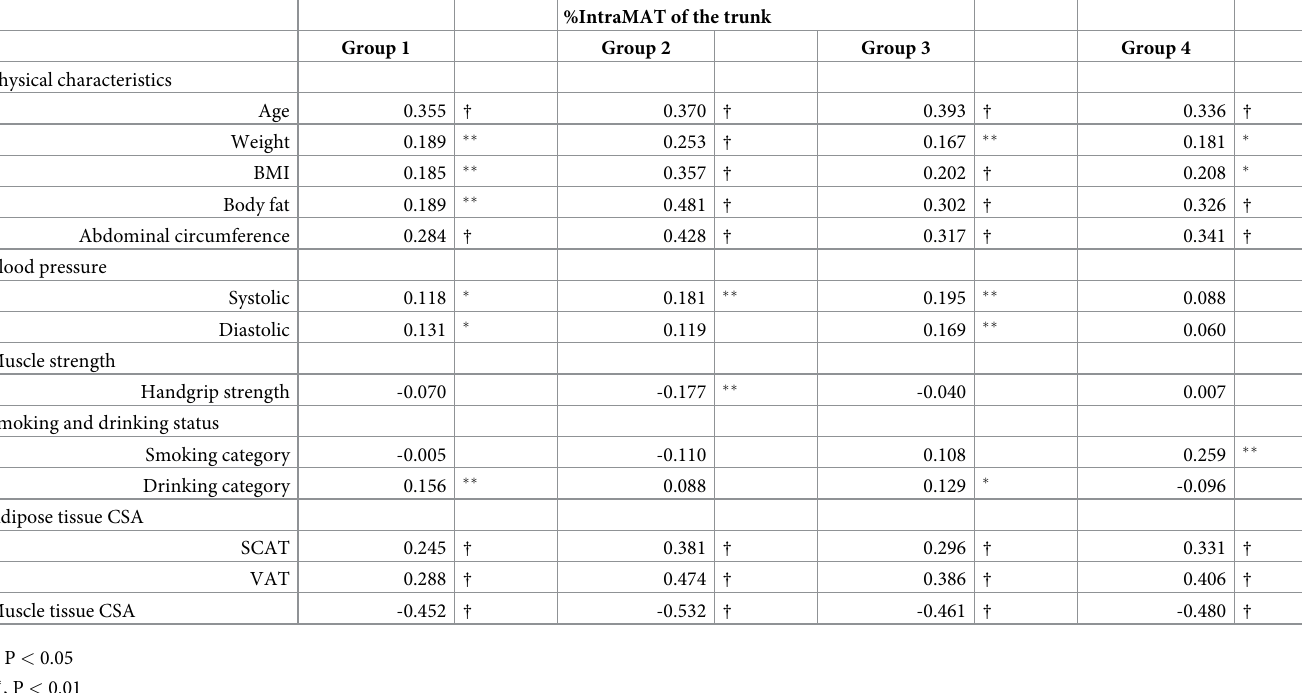
Table 2. Correlation coefficients between %intramuscular adipose tissue (IntraMAT) and characteristics of participants in Groups 1 to